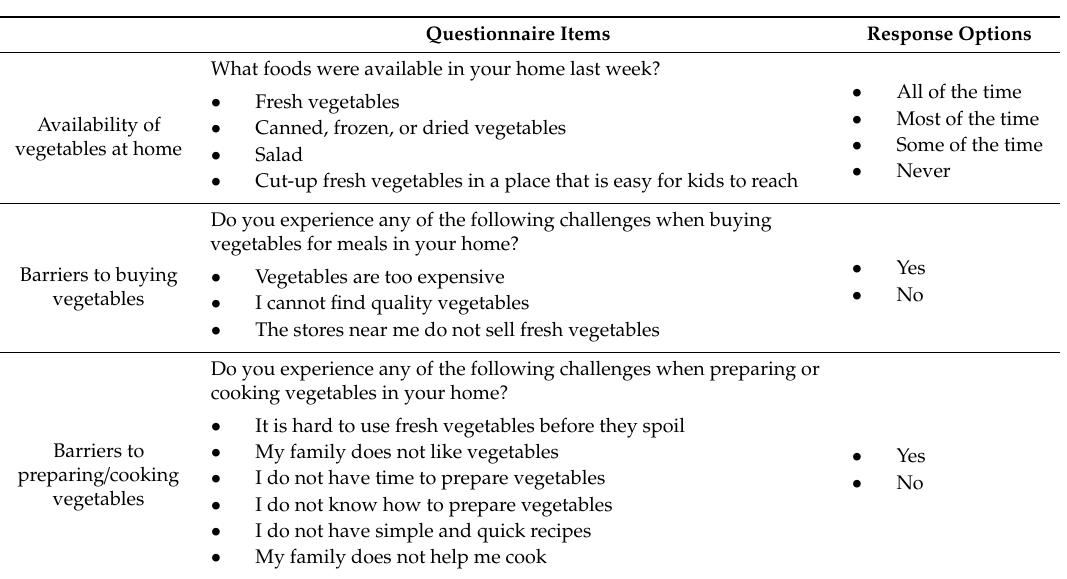
Table 1. Questionnaire items included in the TX Sprouts parent questionnaire assessing availability and barriers to buying and preparing / cooking vegetables.